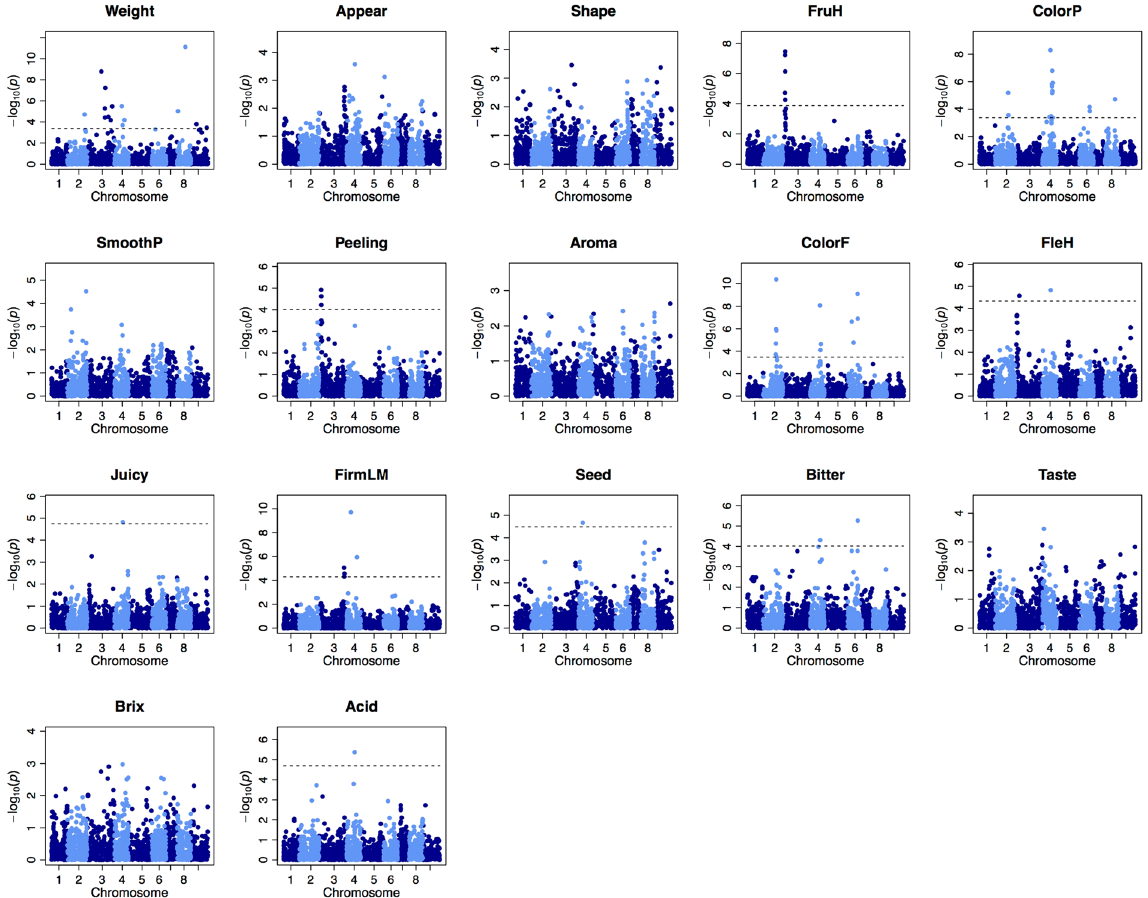
Figure 3. Manhattan plots for 17 fruit quality traits in the combined parental and breeding populations. Mixed linear model used four principal components of population structure as covariates (Supplementary Fig. S6). Dashed lines indicate a false discovery rate of